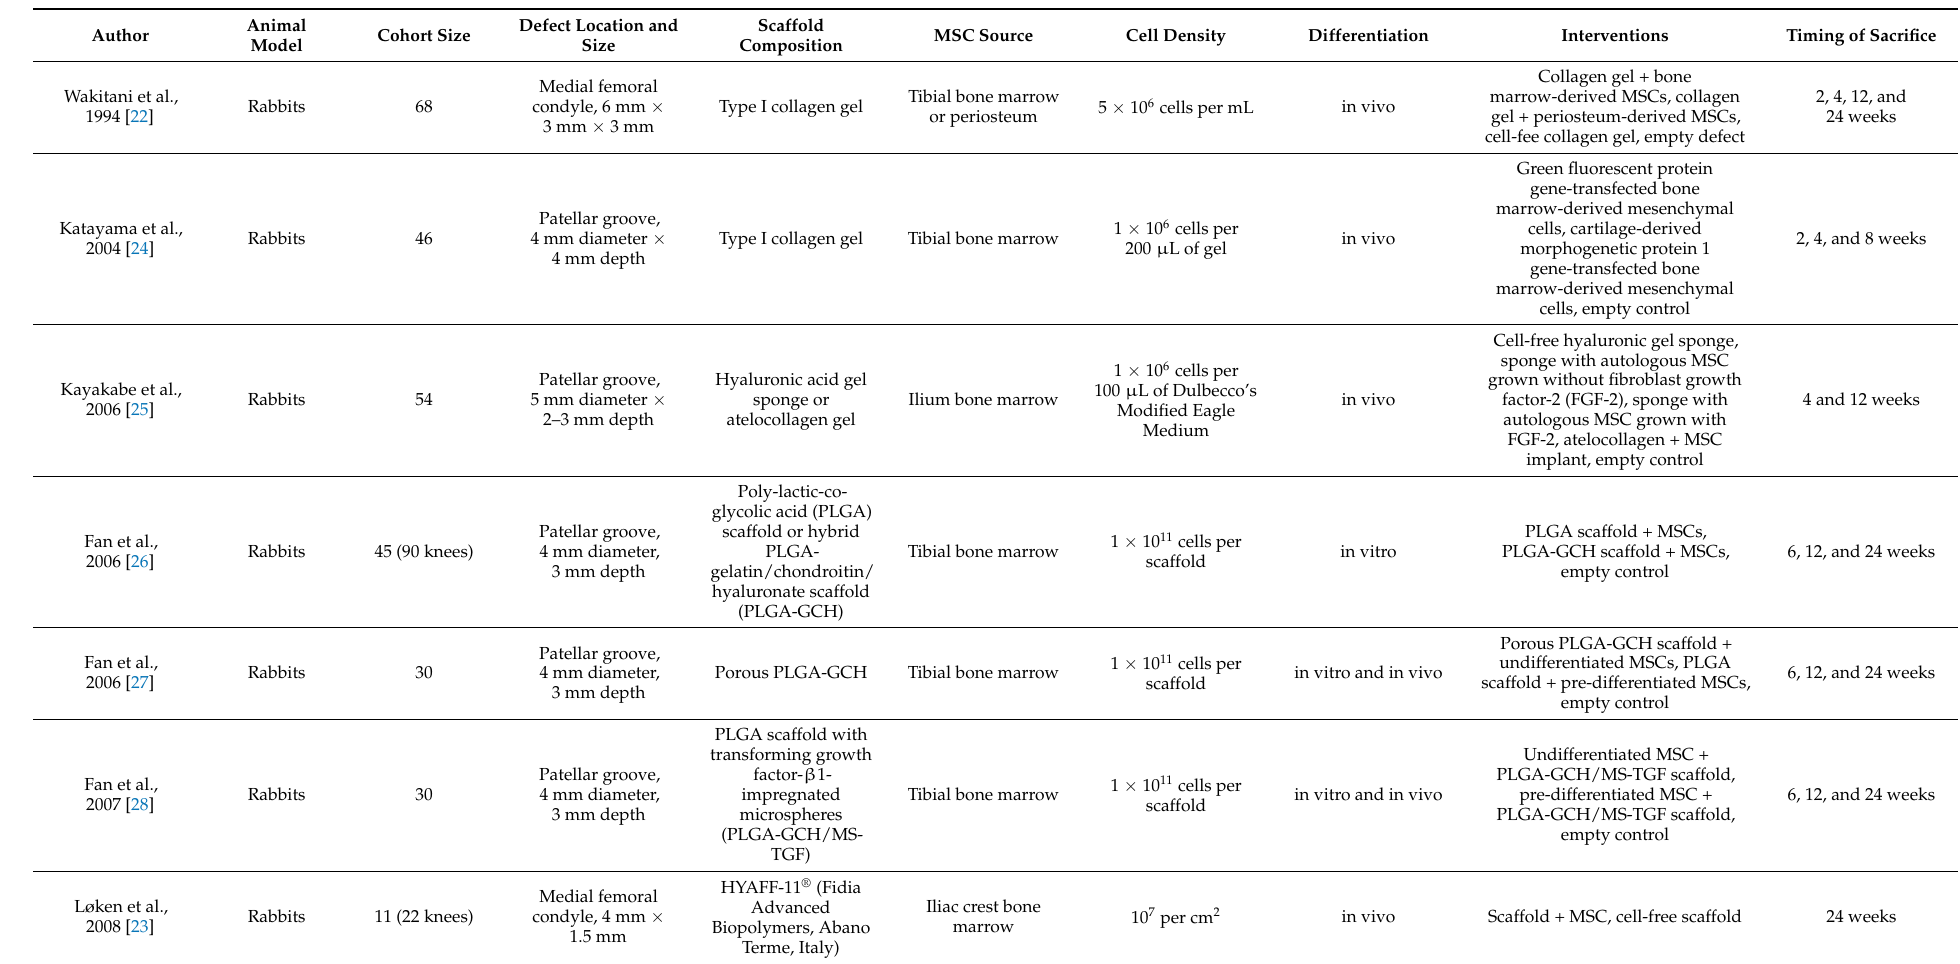
Table 1. Demographics and Study